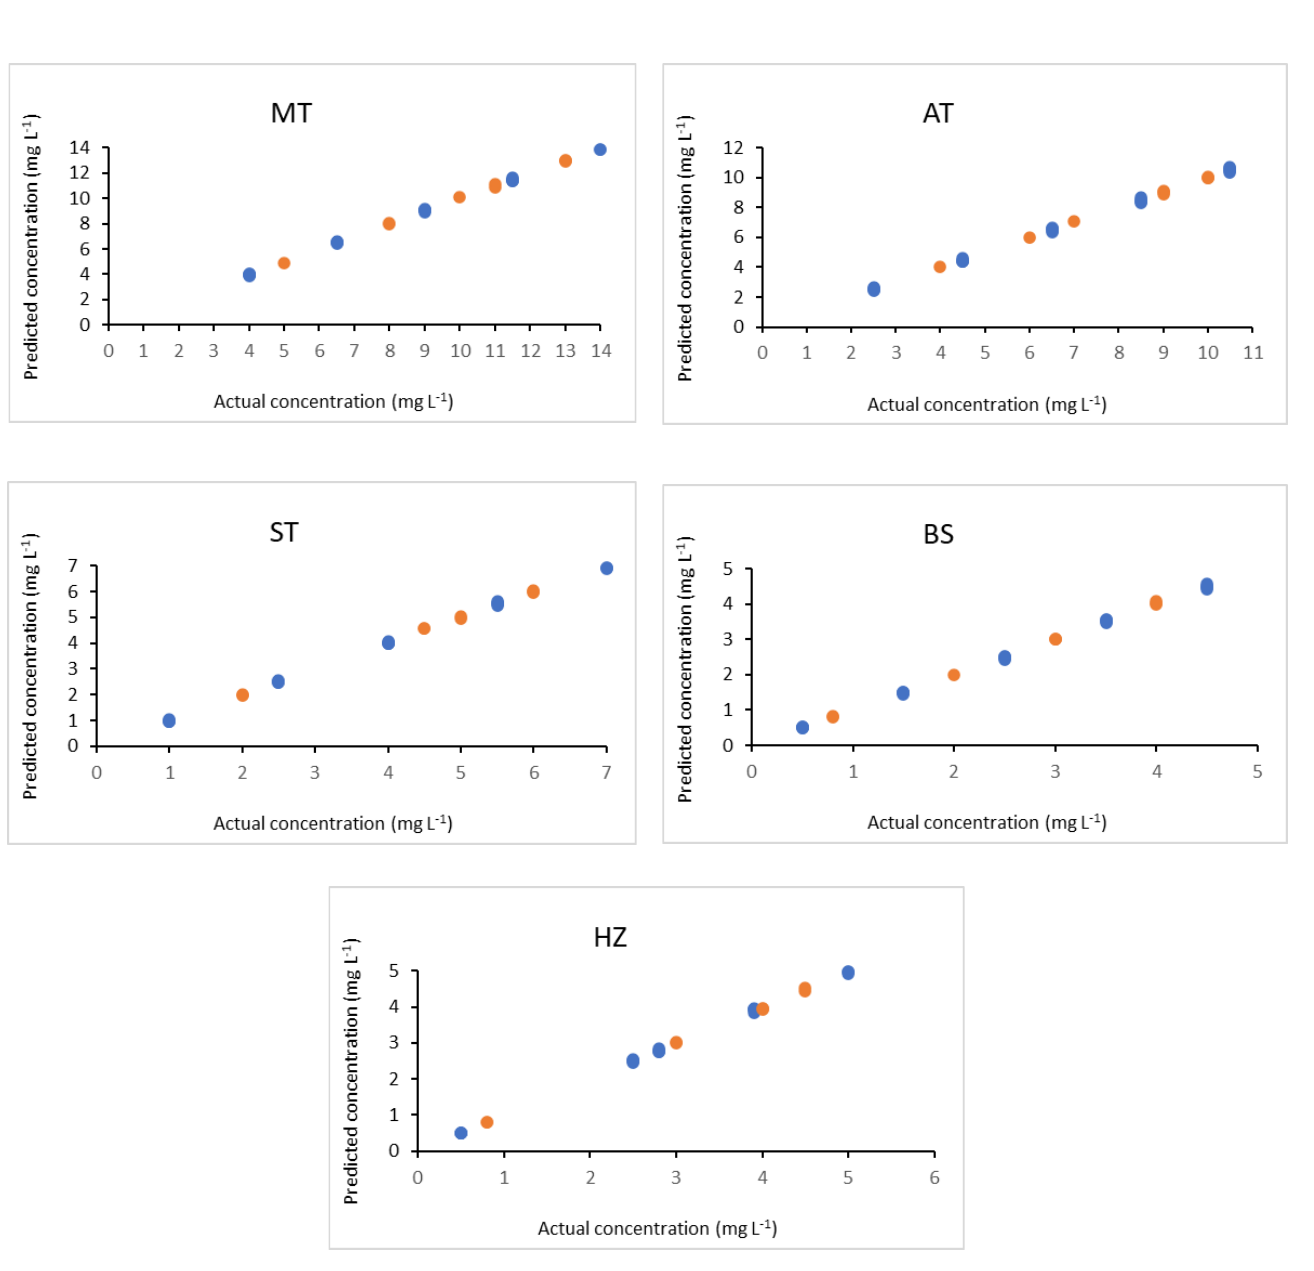
Figure 2. Plot of actual concentrations versus predicted values using MCR-ALS for calibration set ( ) and validation set ( ) of the investigated drugs.